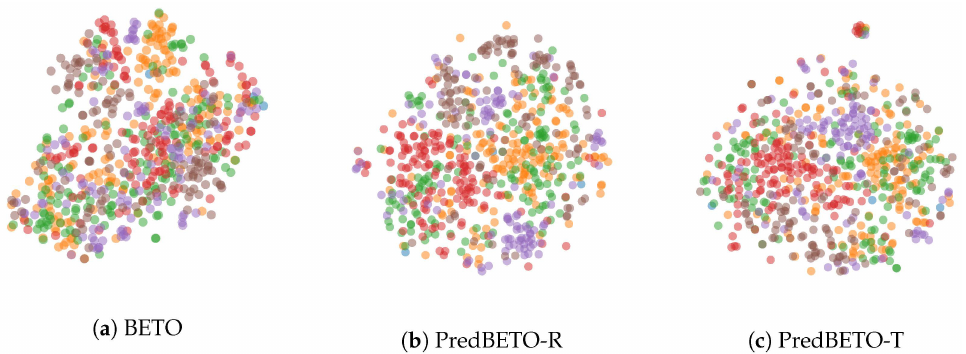
Figure 5. TSNE visualization of the embedding space learned on SQC [65] for BETO and PredBETO in Spanish. Each color indicates a ground truth semantic